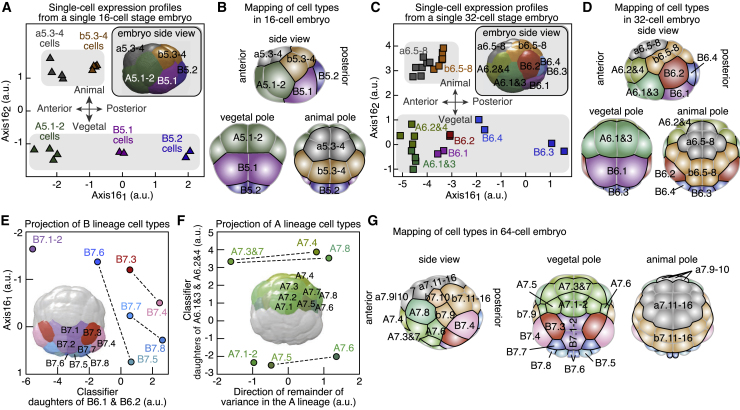
Single-Cell Gene Expression Profiles Map the Spatial Organization of the Embryo(A) Projection on Axis161 and Axis162 of single-cell transcriptomes of all 16 cells of a 16-cell embryo. Inset: 16-cell embryo side view.(B) Mapping of cell types in a 16-cell embryo.(C) Projection on Axis161 and Axis162 of single-cell transcriptomes of 29 cells of a 32-cell embryo. Inset: 32-cell embryo side view.(D) Mapping of cell types in a 32-cell embryo.(E and F) (E) or of A lineage cell types on the classifier of the daughters of A6.1 and 3 and A6.2 and 4 and the direction of the remainder of the variance in the A lineage. (F). Inset: 64-cell embryo vegetal pole. B7.6 belongs to the germ cell lineage. Dashed lines link sister cell types.(G) Mapping of cell types in a 64-cell embryo.See also Figures S4 and S5 and Table S2.